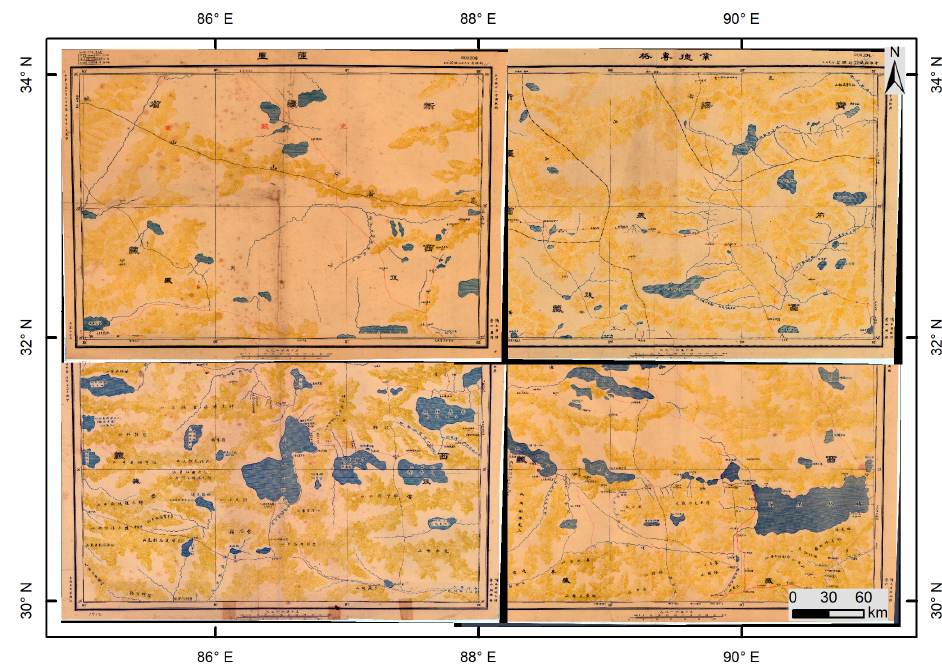
Figure 3. An example showing lake distribution in 1920 on maps of the Republic of China with georeferencing. Maps of the Republic of China are obtained from Academia